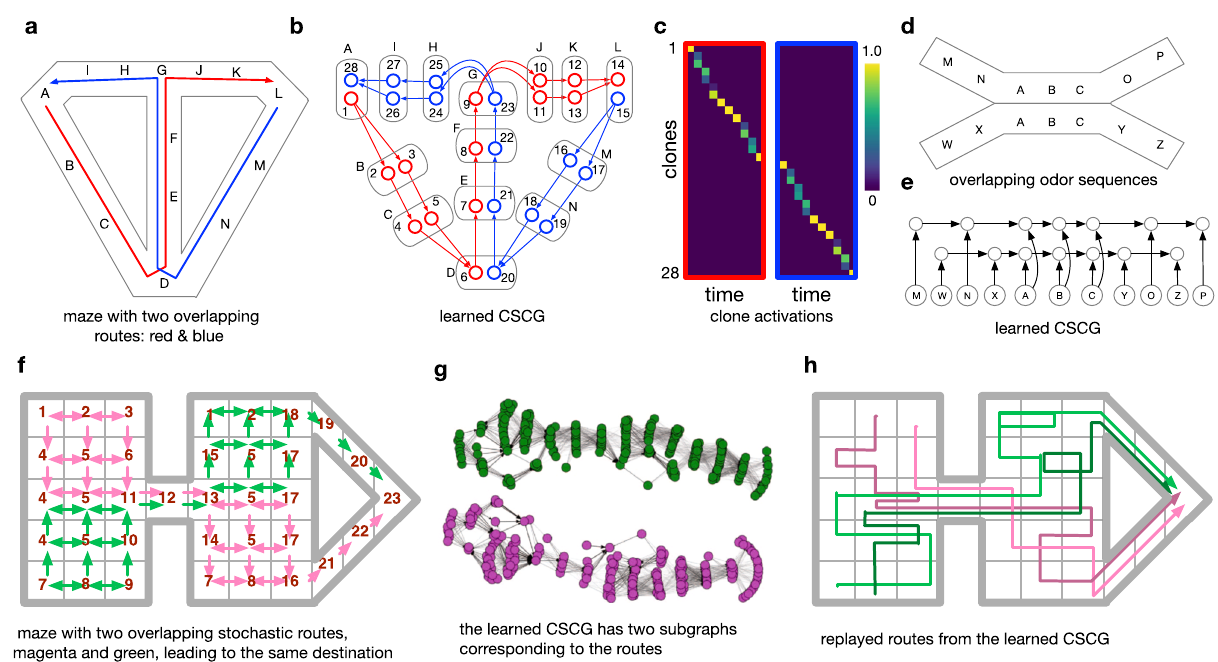
Fig. 4 Learning temporal order and paths. In all experiments, CSCG learned the optimal model for prediction, and the learned circuits matched neurobiological observations. a Modi fi ed T maze from 16 with an overlapping segment between the blue and red paths. A , B , ⋯ , N are the observations at different locations in the maze. b CSCG learns route-differentiated clones for the overlapping segment. (The redundant clones on the non-overlapping segments are identical, and due to the learning algorithm not always using the minimal number of clones). c Activity of the clones for the right trial, and the left trial. Similar to the observations in 16 , the activity of clones in this overlapping segment will indicate whether the agent is going to turn left or right. Distinct neurons are active in the overlapping segment for left-turn trials vs right-turn trials although the observations in the overlapping segment are identical for both trials. Note that clones are not limited to one time step. CSCG learning is able to propagate clones backward into multiple time steps to unravel long overlapping paths. d Overlapping odor sequences from 74 e Full circuit learned by the CSCG shows that it has learned distinct paths in the overlap, as in 74 . f A complex maze in which the agent takes two stochastic paths indicated in magenta and green. Observations in the maze are marked by numbers and, as before, the same observation can be sensed in many parts of the maze. The green and magenta paths overlap in up to seven locations in the middle segment (observations 4-5-11-12-13-5-17). The stochasticity of the paths and the long overlaps make this a challenging learning problem. In contrast to mazes in a and d , the two paths in this maze lead to the same destination as in 20 g . Transition graph learned by the CSCG shows that two different chains are learned for the two routes in f , similar to the observation that place cells encode routes, not destinations 20 . h Paths replayed from the CSCG after it was trained on sequences from f . As they pass through the overlapping segment, the green and magenta routes maintain the higher-order history of where they originated, showing that the learned graph compactly represents the stochasticity and directionality of each route while separating the two routes by appropriately merging and splitting the